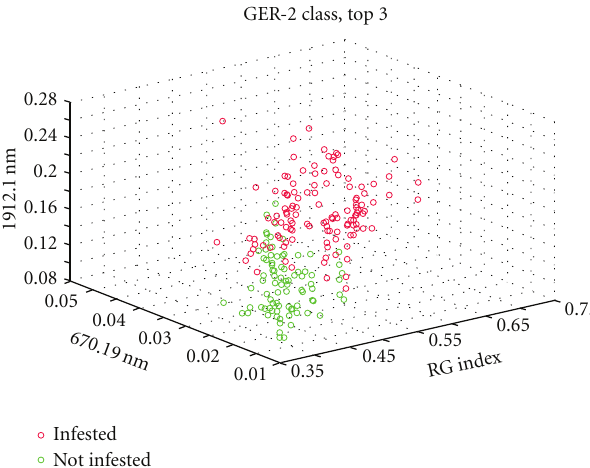
Figure 4: Values for the red green index (ratio of bands centered at 660 nm and 549 nm, resp.), percent reflectance in a narrow band centered at 670 nm, and percent reflectance in the narrow band centered at 1912 nm for individual trees infested or not infested with balsam woolly adelgid. The three variables were selected using a stepwise discriminant analysis procedure for distinguishing infested from noninfested